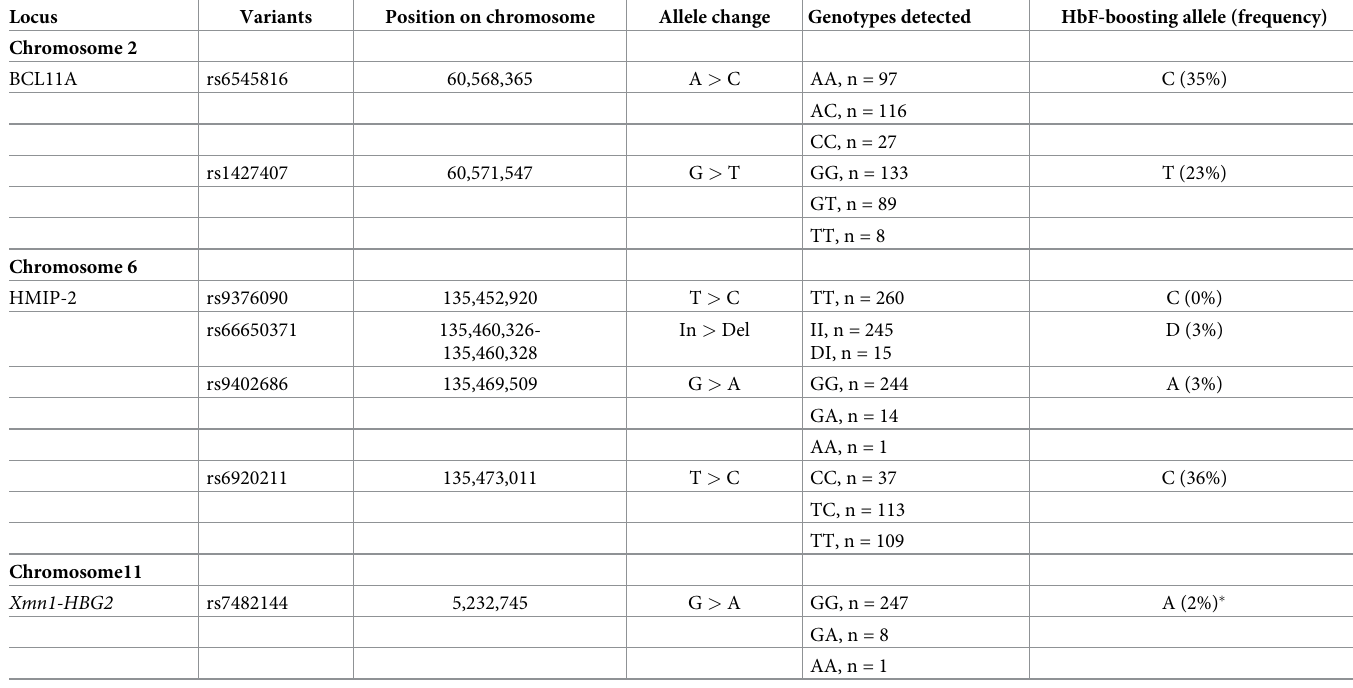
Table 1. Presence and frequency of HbF-boosting genetic variants in Nigerian patients. Locus Variants Position on chromosome Allele change Genotypes detected HbF-boosting allele